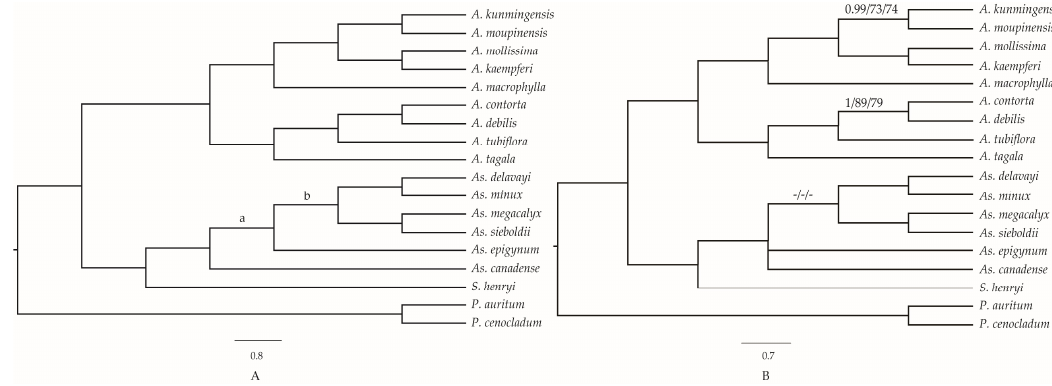
Figure 9. Phylogenetic relationships of the 18 species inferred from maximum parsimony (MP), maximum likelihood (ML), and Bayesian (BI) analyses. ( A ) The topology was constructed by cp genomes, LSC, SSC, CDS, and hotspots regions; ( B ) tree constructed by IR region. Bayesian posterior probability values < 0.95 or Bootstrap values < 90 were marked on the branches. The support values in node (a): 1/86/93 (using LSC region), 0.97/78/84 (SSC), 0.82/-/- (CDS), and 1/81/80 (hotspots); (b): 1/90/79 (SSC) and 1/73/71 (hotspots). Numbers above nodes are support values with Bayesian posterior probabilities values on the left, ML bootstrap values in the middle, and MP bootstrap values on the right. “ - “ indicates the value < 70.